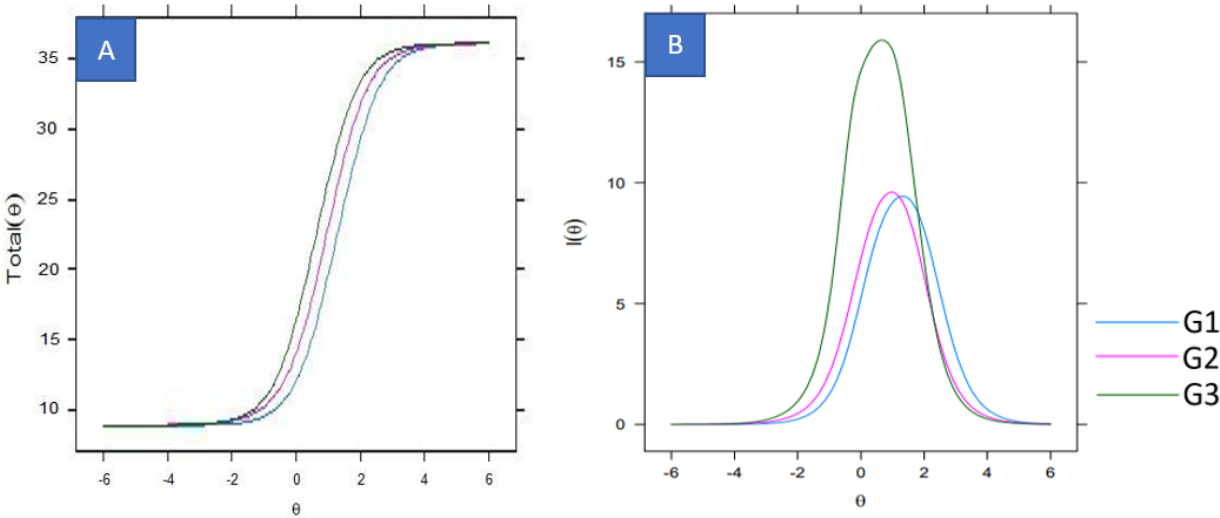
Figure 2. Instrument ( A ) and information curve ( B ) graphs.